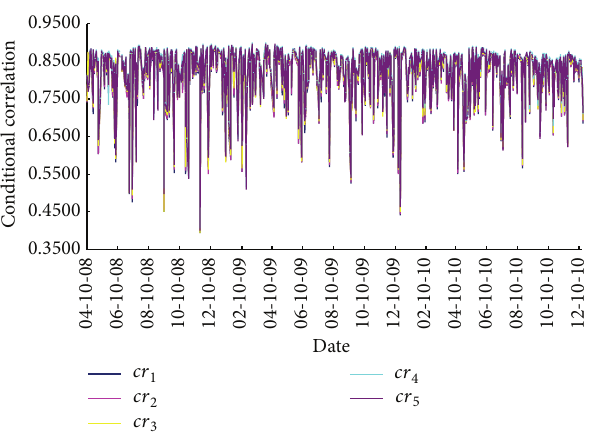
Figure 5: Time-varying hedge ratios of futures contracts with different maturities.